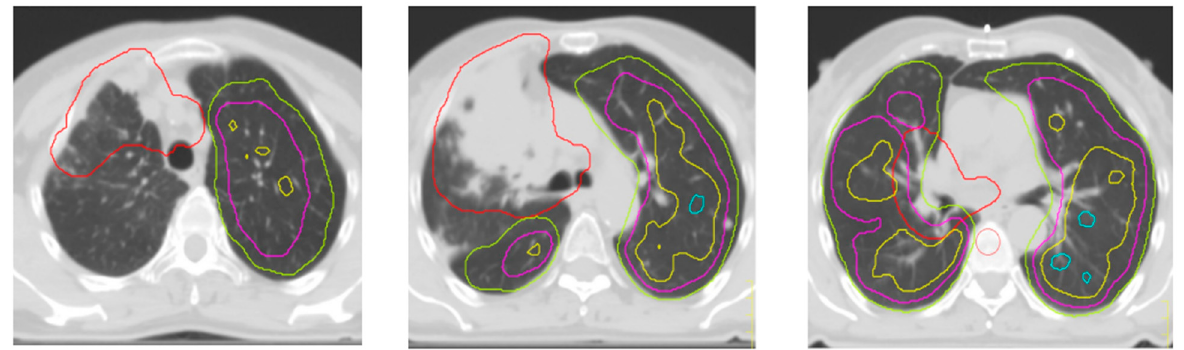
Figure 2. Red : PTV ; green: isoROI 20%; magenta: isoROI 40%; yellow: isoROI 60%; light ‐ blue: isoROI 80%.